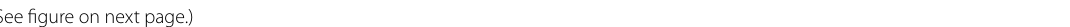
figure on next Fig. 1 Alignment of the deduced amino acid sequences of SdCPR and plant P450 reductases. The deduced amino acid sequences of SdCPR was aligned with those of CPRs from Pisum sativum (PsC405R1), Gossypium hirsutum (GhCPR2), Arabidopsis thaliana (ATR2), G . hirsutum (GhCPR1), Withania somnifera (WsCPR1), and A . thaliana (ATR1) using the ClustalW program. Descriptions of CPRs used in the alignment are listed in Additional file 1: Table S2. The conserved regions and binding sites are